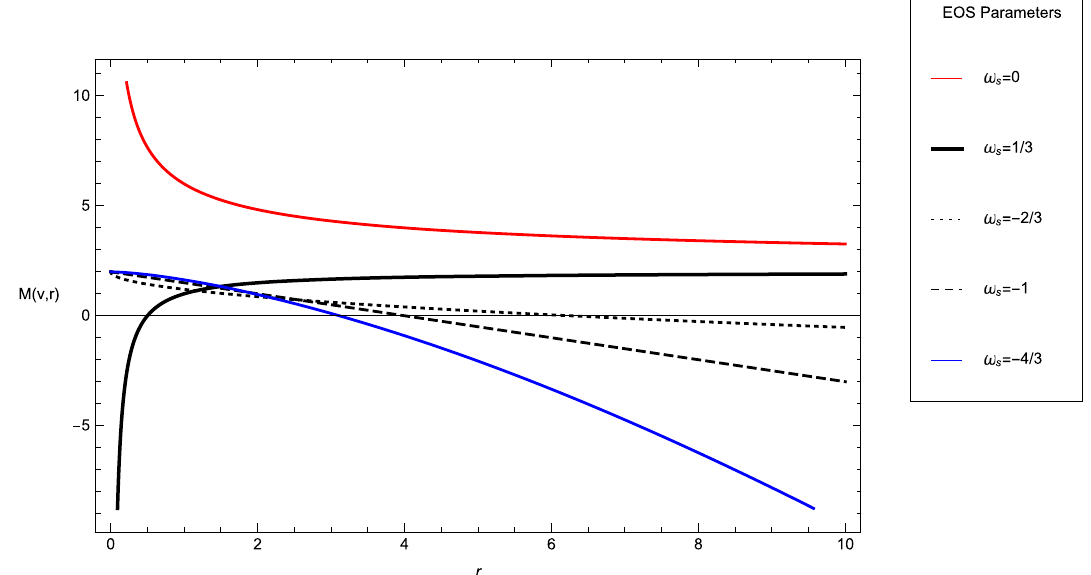
Fig. 2 Plot indicating the radial evolution of the mass function with respect to each of the matter field parameters